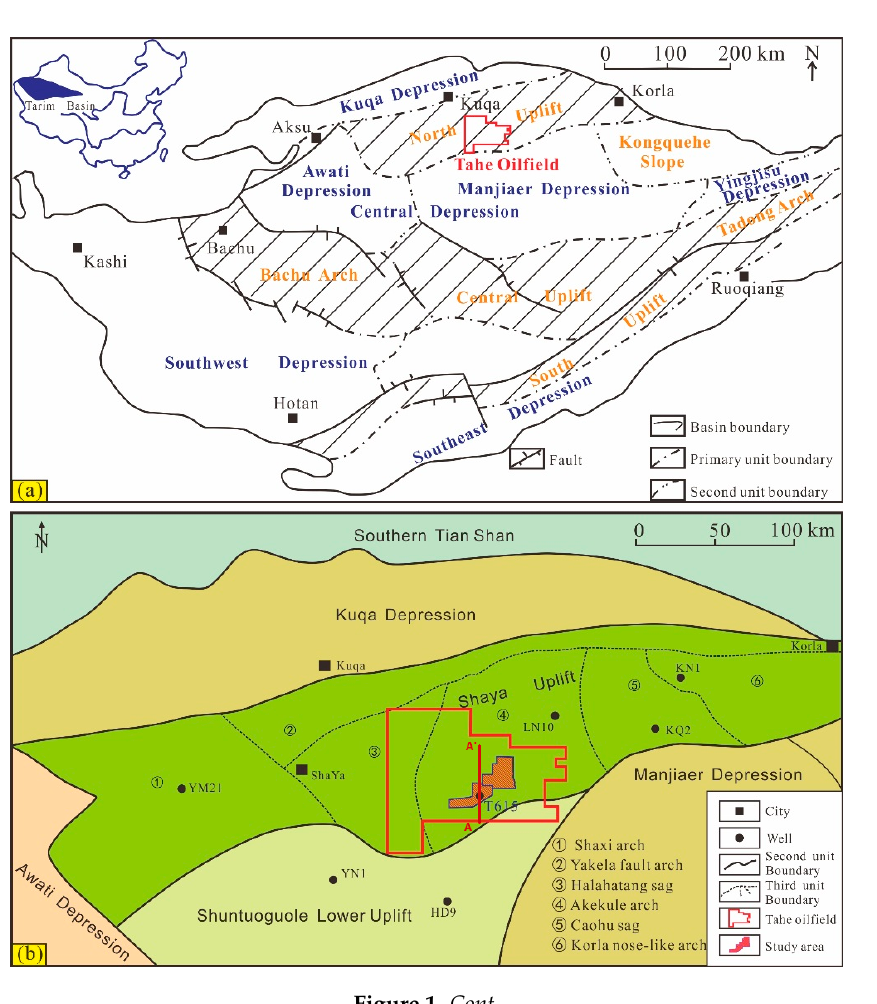
Figure 1. Location of the study area and overview map of the Tarim Basin. ( a ) Tectonic components of the Tarim Basin, including three uplifts and four depressions with east-west orientations (reference